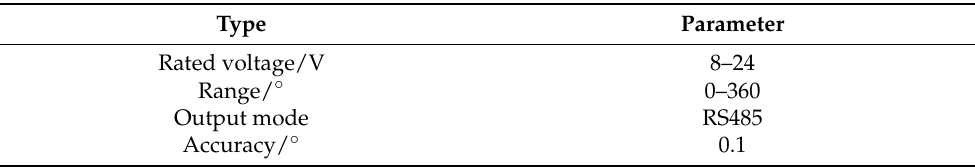
Figure 2. Installation schematic diagram of angle sensor. ( a ) Structure diagram; ( b ) installation drawing: 1. Steering shaft; 2. Trellis bar; 3. Angle sensor; 4. Fixed bracket; 5. Fixed link; 6. Ball tie rod. Table 2. Parameters of angle sensor.